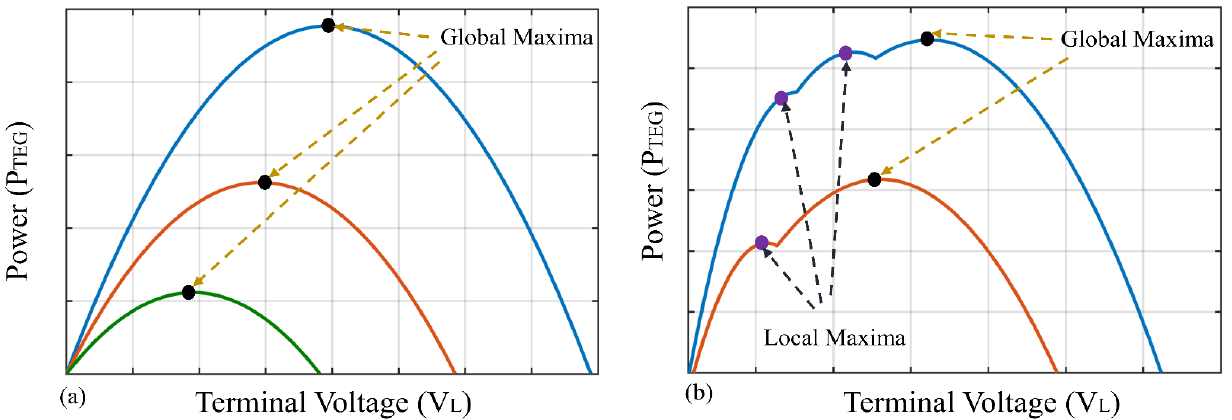
Figure 3. ( a ) Total power vs. terminal voltage relationship under uniform temperature distribution. ( b ) Total power vs. terminal voltage relationship under nonuniform temperature distribution.